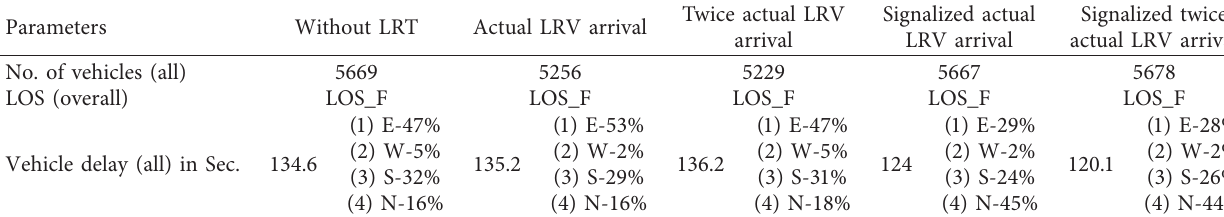
Table 4: CMC level crossing simulation